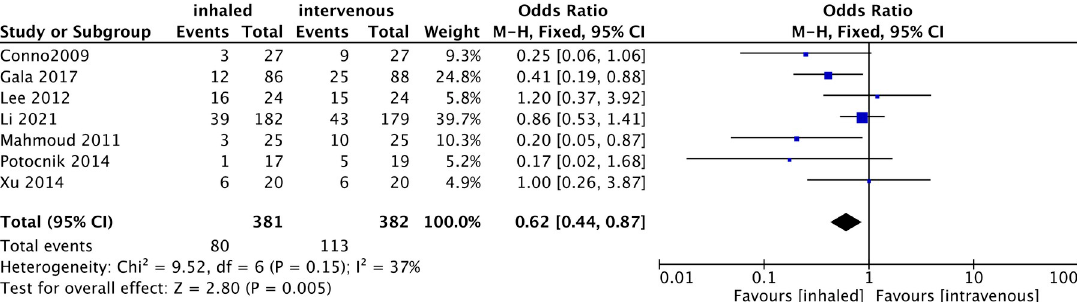
PLOS ONE | https://doi.org/10.1371/journal.pone.0266988 October 20,